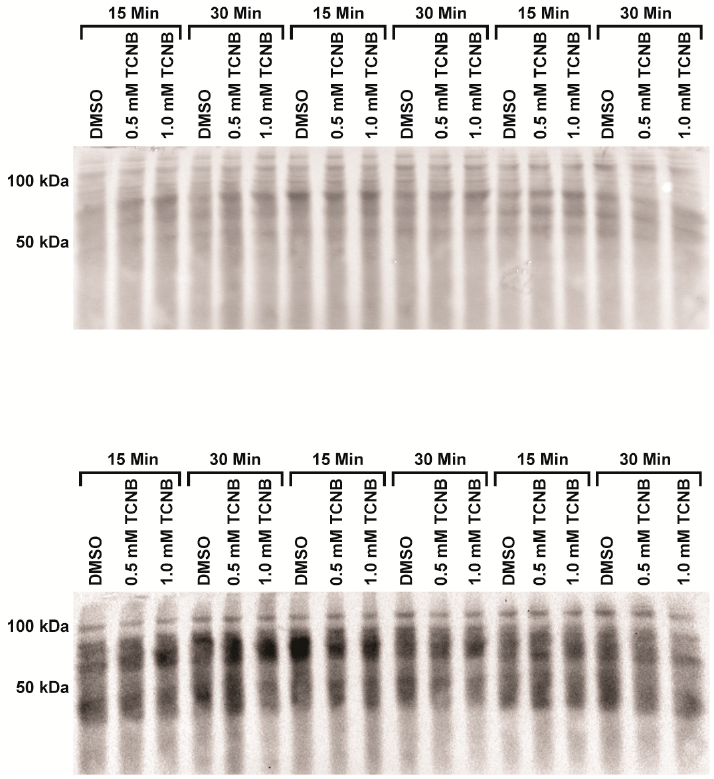
Figure 7. Effect of 3,4,5-TCNB treatment on protein carbonylation in IRCC from three different animals using OxyBlot. The top panel represents the total protein, while the bottom panel represents the carbonylated proteins. n = 3 separate experiments.